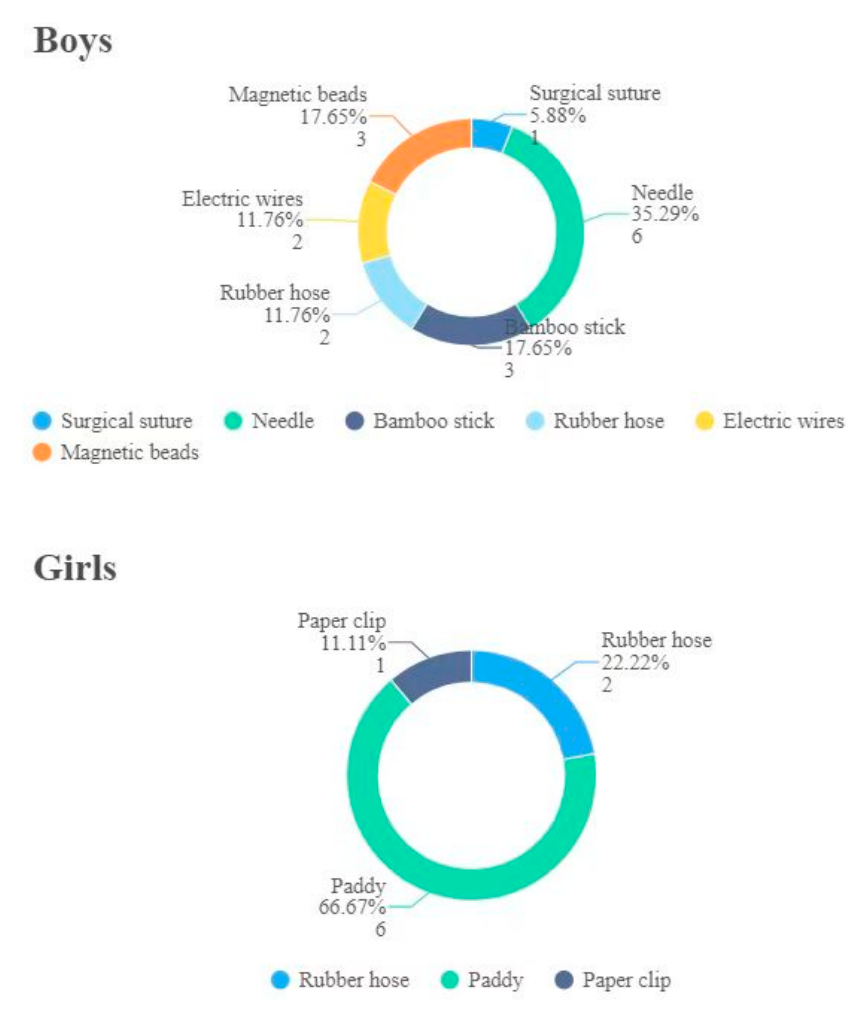
Figure 3. Type and quantity of urethral foreign bodies in boys and girls.